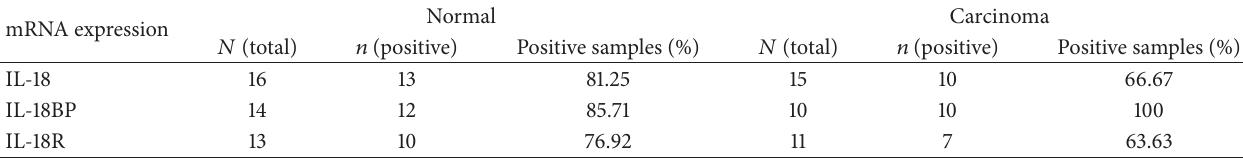
Table 2: IL-18, IL-18BP, and IL-18R mRNA expression in normal and cancerous ovarian homogenates. mRNA expression